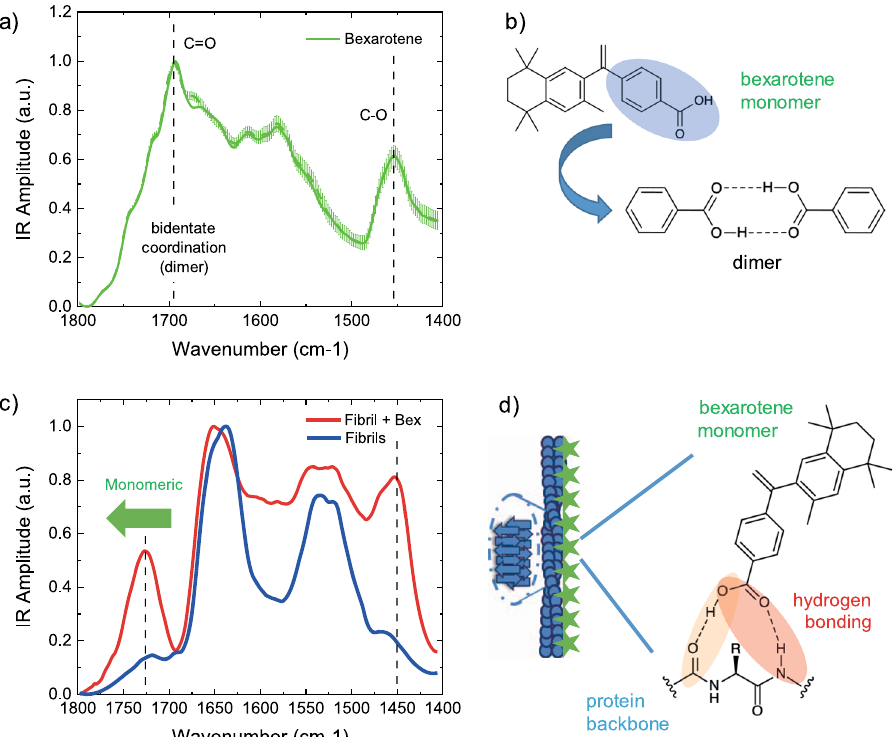
Fig. 4 Bexarotene interacts with A β 42 aggregates through hydrogen bonding of its carboxyl group. a AFM-IR spectrum of a bexarotene (Bex, green) fi lm deposited on a gold substrate. We represent two spectra: (i) the average + SE of the raw spectra ( n = 12), and (ii) the average + SE of the preprocessed spectra ( n = 12) by applying an adjacent averaging fi lter (5 pts) and a Savitzky – Golay fi lter (second order, 15 pts). Five different raw spectra at each position (coloured crosses) were acquired. b Bexarotene alone has strong tendency to form dimers stabilised by two hydrogen bonds corresponding to a C = O IR absorption at 1690 cm − 1 , compared to the 1720 – 1745 cm − 1 range of bexarotene forms with one hydrogen bond (Supplementary Fig. 9) 47 . c A β 42 fi brils show the typical spectrum of proteins (blue), while fi brils incubated with bexarotene (red) show an additional chemical signature related to the small molecule and with a frequency of absorption at ~1725 cm − 1 , demonstrating that bexarotene is in the monomeric form and interacting with the fi brils through a single hydrogen bonding (red or orange). d Schematic of the fi bril (blue) and bexarotene (green stars) interaction through hydrogen bonding. When bonded with the fi bril or oligomer, bexarotene is likely to assume a conformation such that its bulky part is projected away from the nearest amino acid side